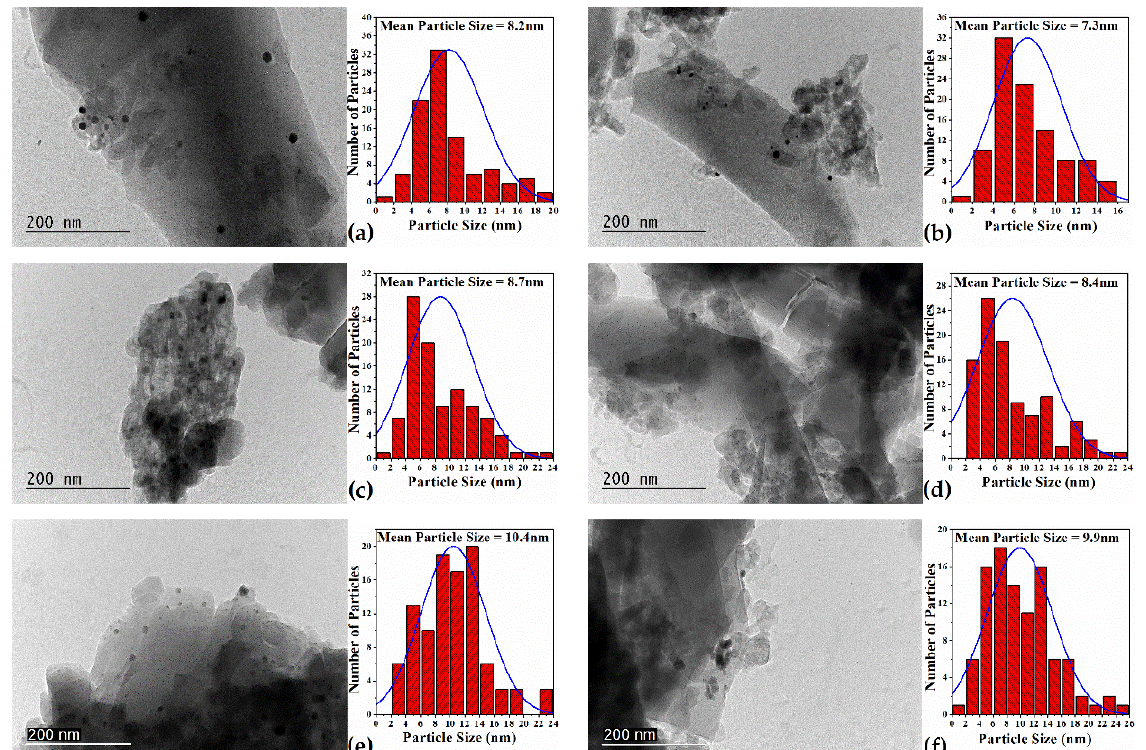
Figure 3. TEM images of parent and treated impregnated samples: ( a ) Pt parent, ( b ) Pt treated, ( c ) Cu parent, ( d ) Cu treated, ( e ) Pd parent, ( f ) Pd treated and its corresponding particles’ size distribution.